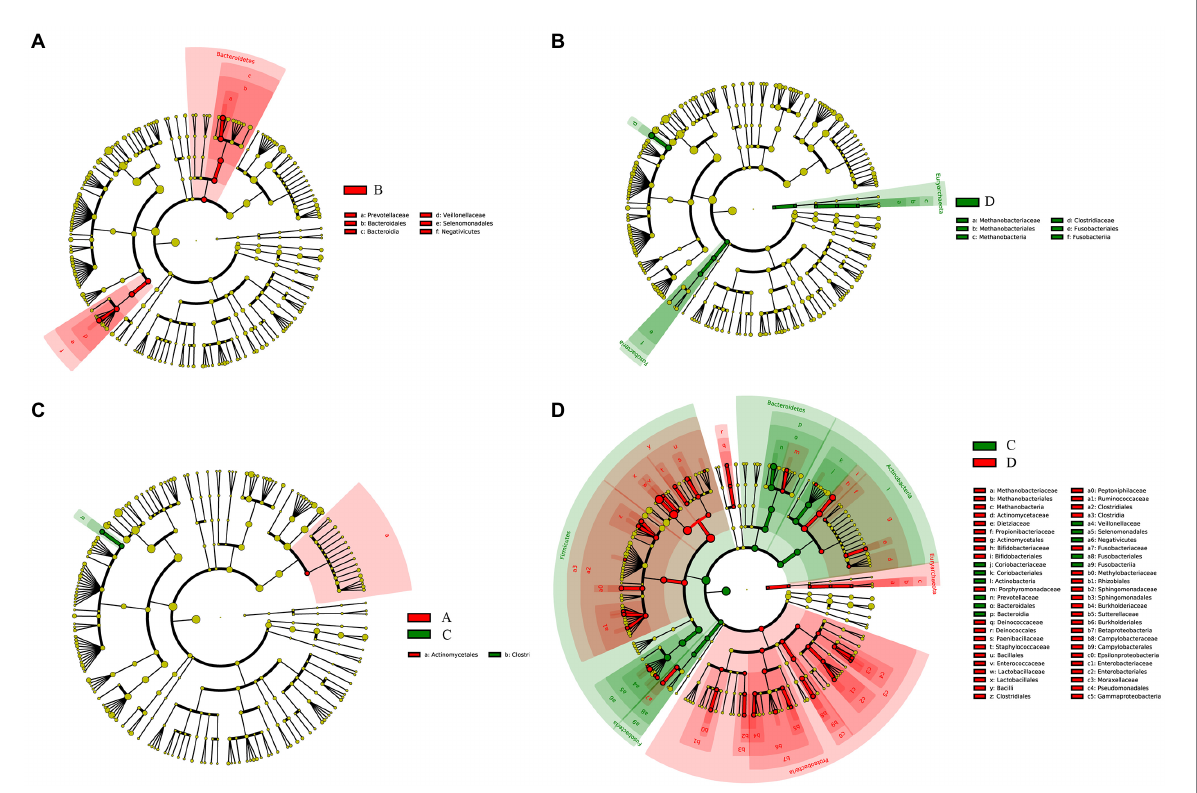
FIGURE 3 Taxa difference analyses between Group A and Group B (A) , Group C and Group D (B) , Group A and Group C (C) , and Group C and Group D (D) by LEfSe analysis,